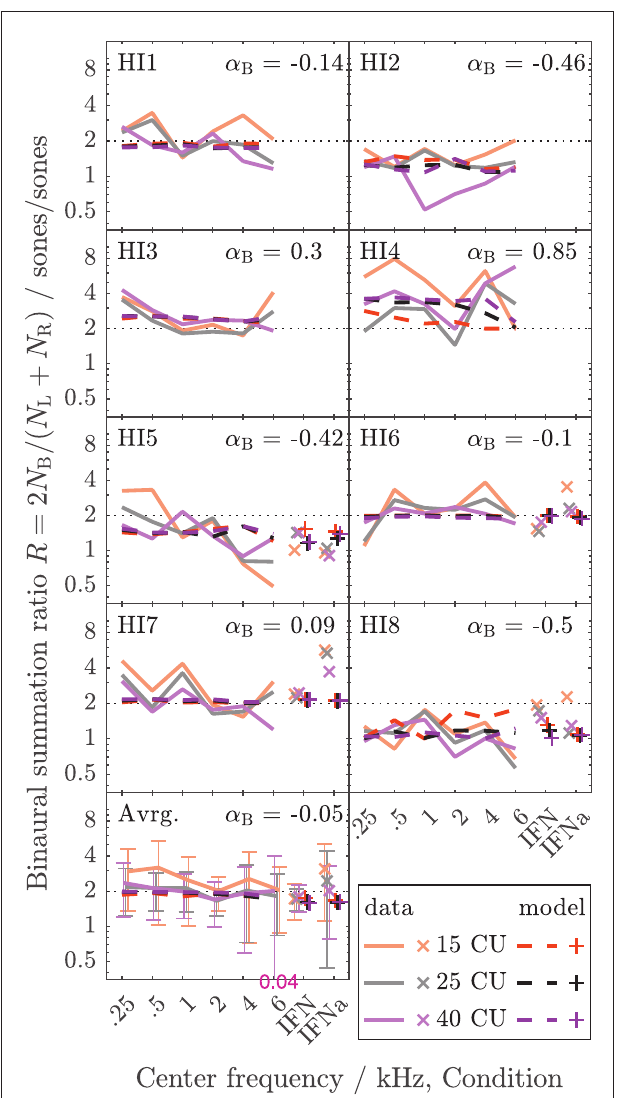
FIGURE 3 | Loudness ratios R = 2 N B / ( N L + N R ) between loudness for diotic presentation N B in sones and summed monaural loudness N L + N R in sones for the NH listeners of Dataset 1. The lines indicate diotically presented narrowband LNN stimuli with different center frequencies (0.25, 0.5, 1, 2, 4, and 6kHz). Broadband IF noise stimuli with frontal incidence for unaided (IFN) and aided (IFNa) conditions are indicated with symbols. The colors indicate the loudness in CU for the diotic condition (orange: 15 CU, “soft,” gray/black: 25 CU, “medium,” purple: 40 CU, “loud–very loud”). The empirical data are shown as solid lines (narrowband stimuli) and x symbols (broadband stimuli) in lightened colors. Dashed lines and + symbols indicate the respective model calculations of the individualized binaural stage (the individual values for α B are given for each listener). The bottom panel shows the averaged data across the NH listeners. Standard deviations are indicated with error bars. NH listeners with the exception of NH3, whose data show